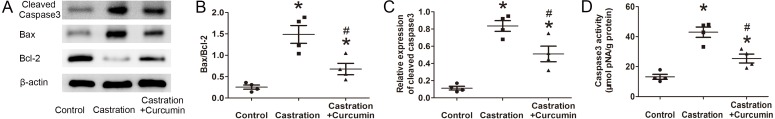
Apoptosis in seminal vesicle.(A) Representative western blot results for Bcl-2, Bax, and Cleaved caspase3. (B) Ratio of Bax to Bcl-2; n = 4 for each group. (C) Relative expression of Cleaved caspase3; n = 4 for each group. (D) Caspase3 activity detected with a kit; n = 4 for each group. * P < 0.05 compared with control group. # P < 0.05 compared with castration group.